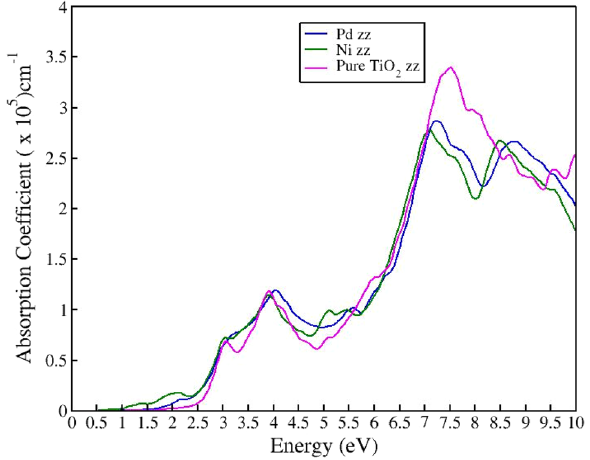
Fig. 5 Extinction coefficient of Ni, Pd and Pure TiO